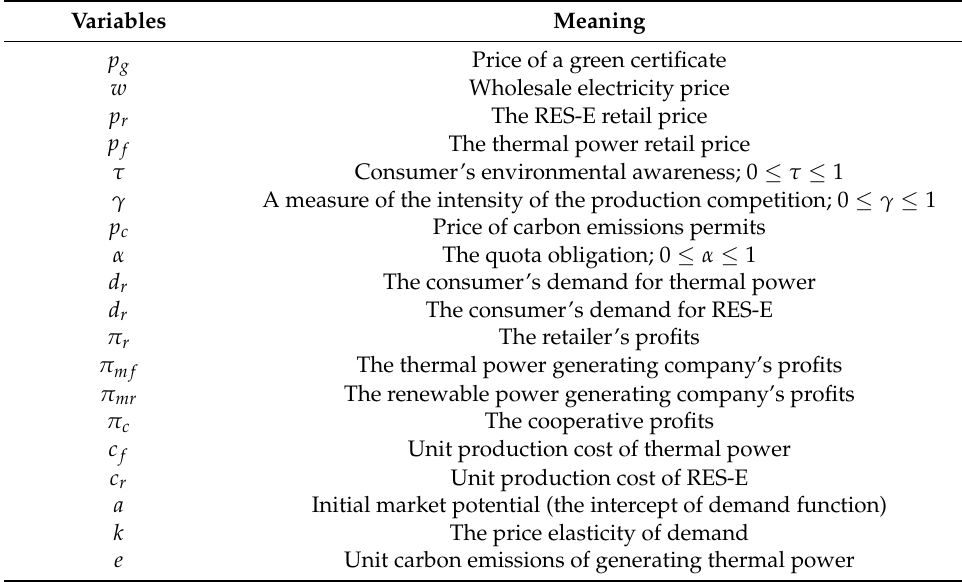
Table 1 defines the notations of the model. Table 1. Decision variables, variables, and